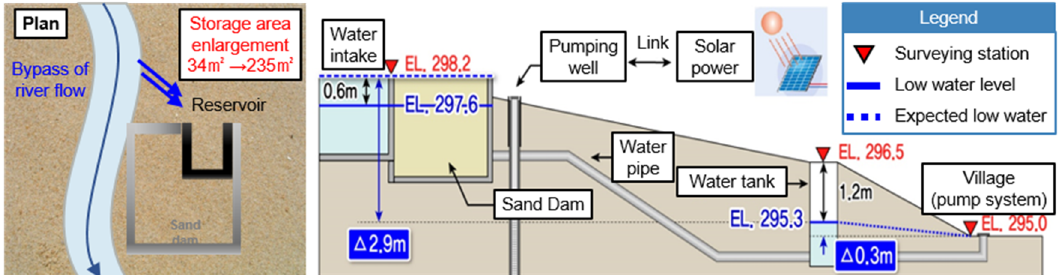
Figure 4. Schematics of the water supply from the sand dam.